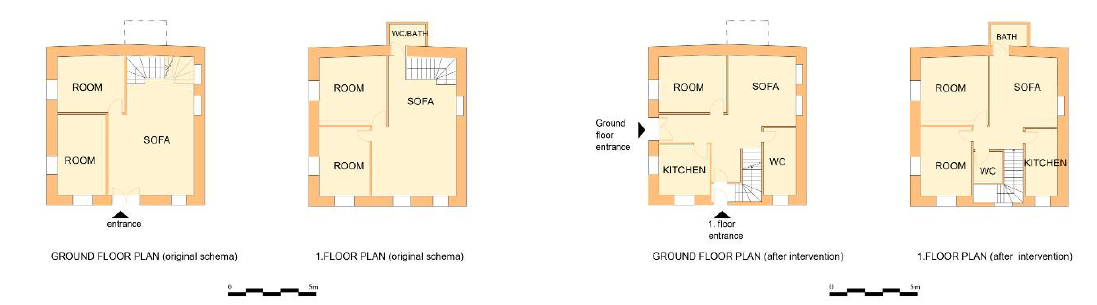
Figure 21 A house plan before and after the intervention (illustration: